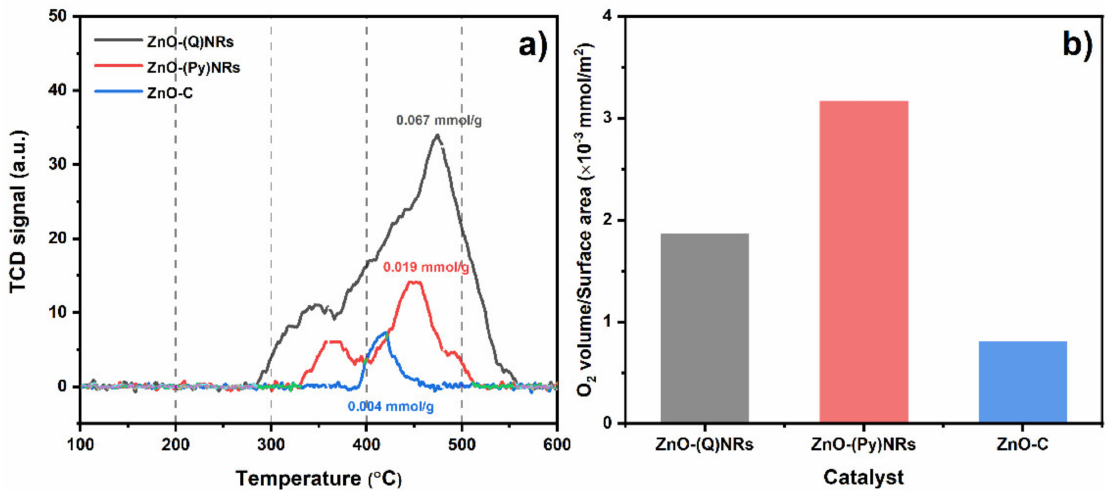
Figure 5. ( a ) O 2 -TPD profiles for as-synthesized ZnO-(Q)NRs, ZnO-(Py)NRs, and ZnO-C. ( b ) Surface area-normalized volume of desorbed O 2